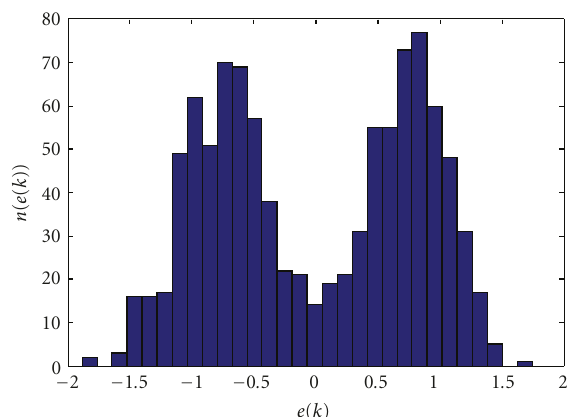
Figure 1: Histogram of successfully extracted source at equalizer’s